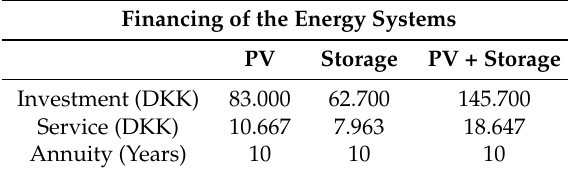
Figure 2. Overview of the energy flow in the case study. Table 3. Structure of the economic investment for the different